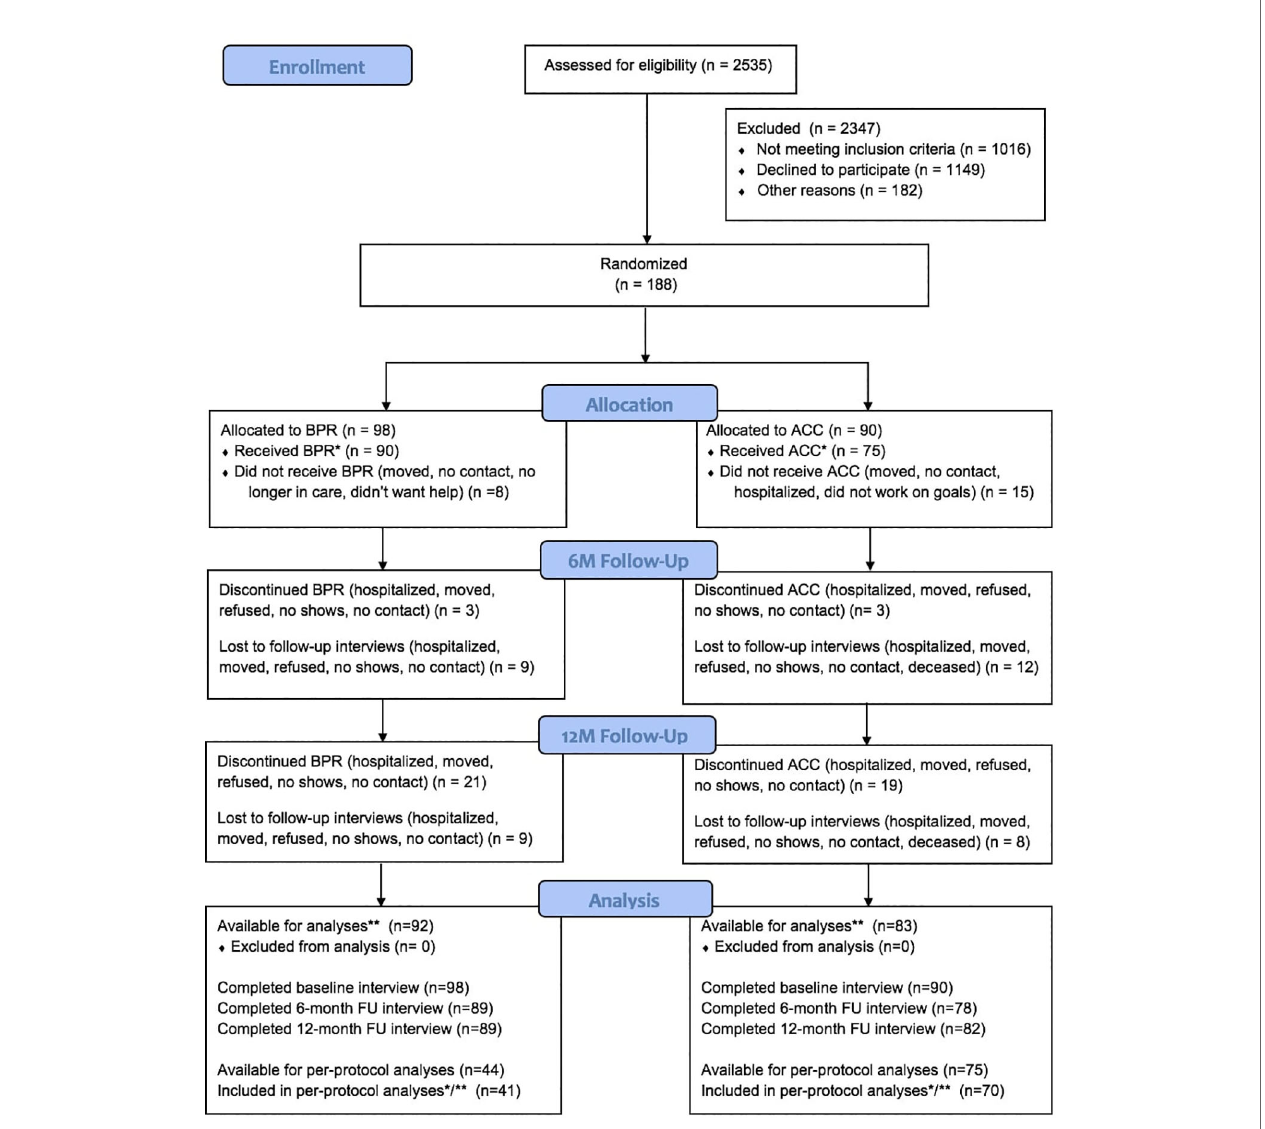
FIGURE 1 | CONSORT fl ow chart. * Received at least 3 sessions. ** Participants with baseline and 6-month or baseline and 12-month measurement, or all measurements (in multilevel modeling, all available data on outcome are